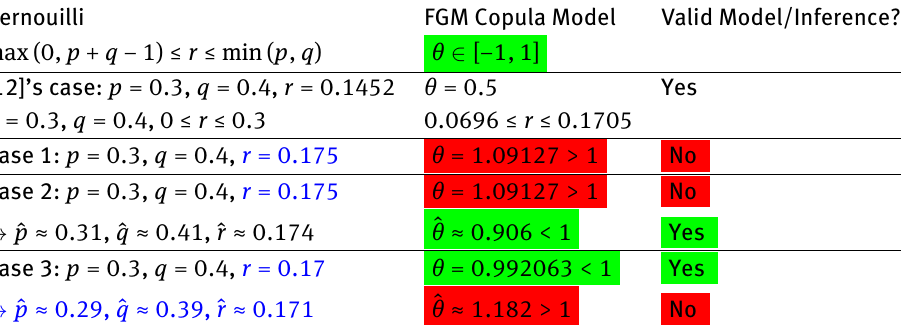
Table 1: Bernoulli distribution with FGM copula Bernouilli FGM Copula Model Valid